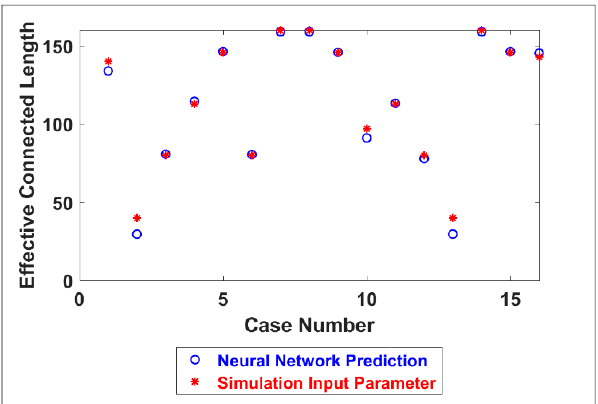
Figure 28. Inverse model prediction comparison with the simulation input parameters.